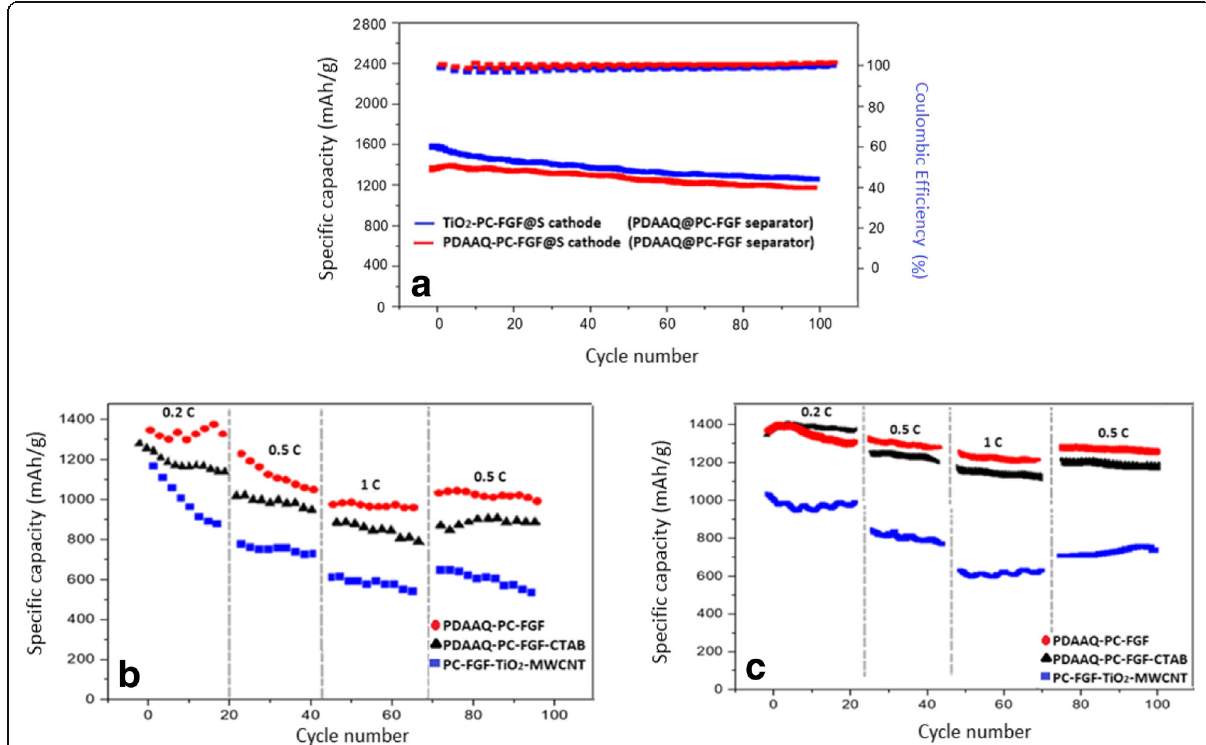
Fig. 5 a Cycling performances and Coulombic efficiencies of Li-S cells with PDAAQ/PC-FGF separator and two different cathodes at 0.2 C. b Rate performance of Li-S cells with PDAAQ/PC-FGF/S cathode and three different separators. c Rate performance of Li-S cells with TiO 2 /PC-FGF/S cathode and three different